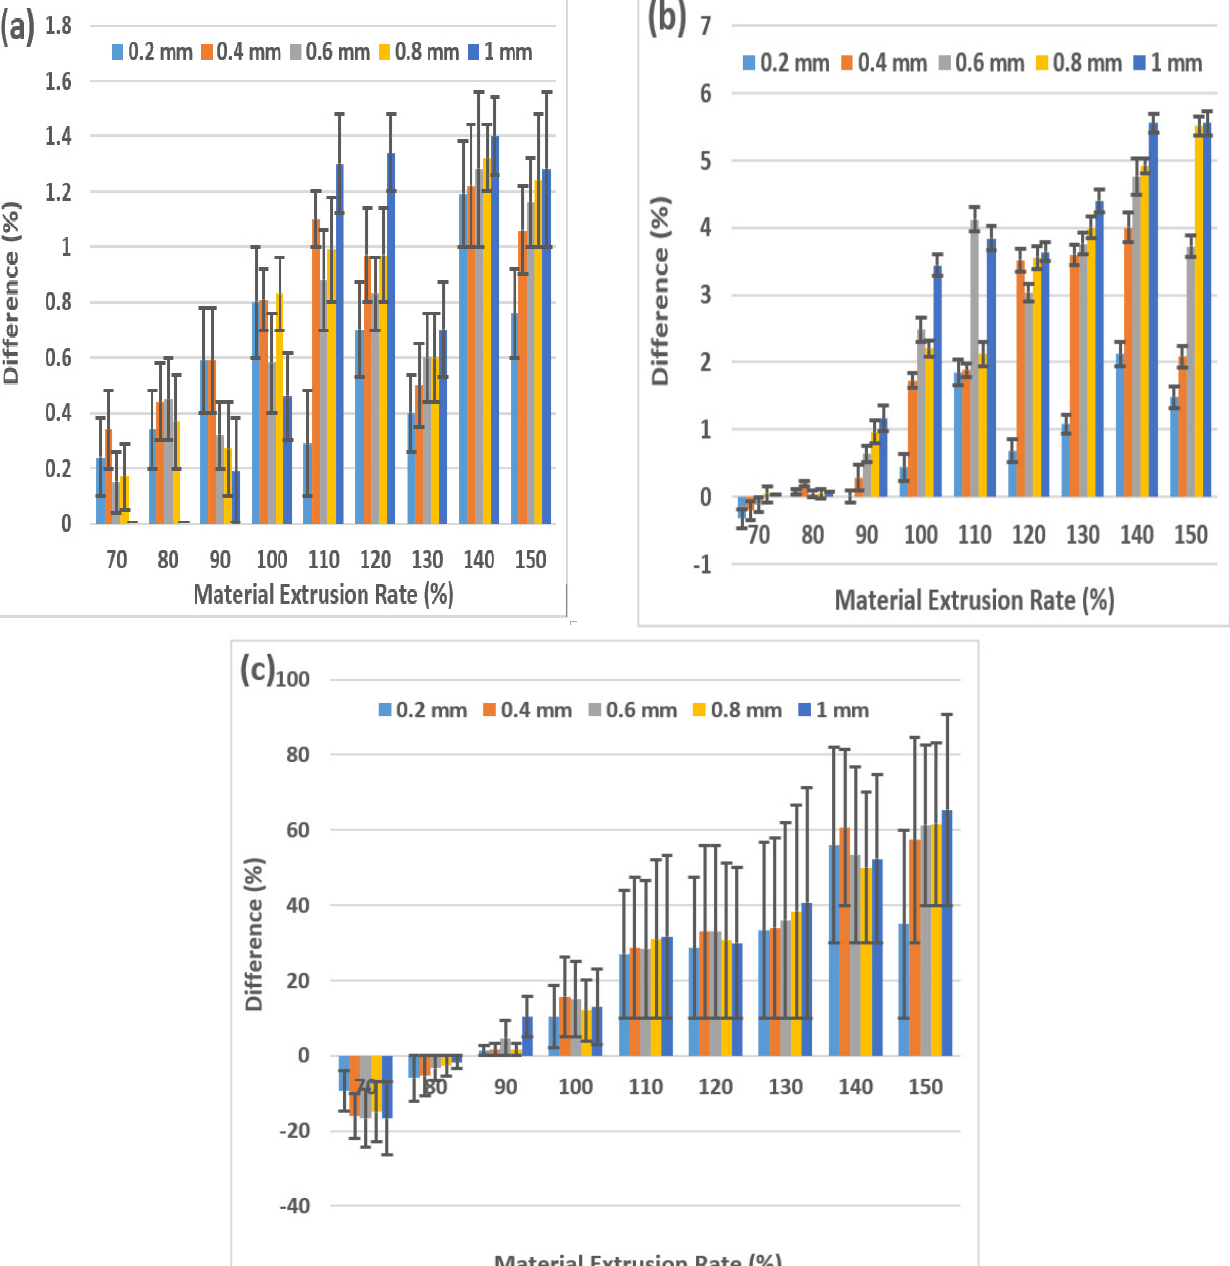
Figure 4. Dimensional analysis: ( a ) along X-axis; ( b ) along Y-axis; and ( c ) along Z-axis.